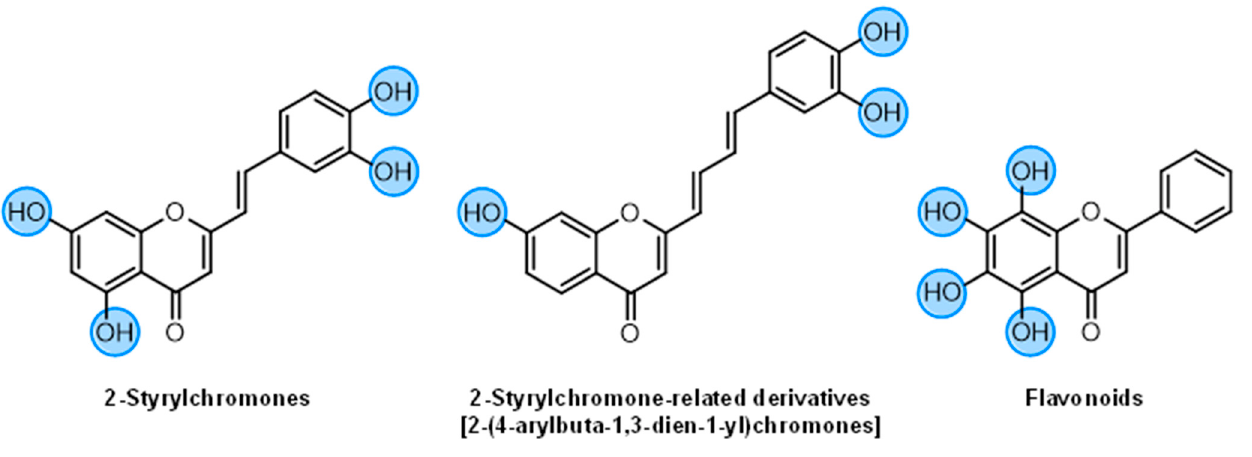
Figure 7. Structure–activity relationship of chromone derivatives: 2-styrylchromones, 2- styrylchromone-related derivatives [2-(4-arylbuta-1,3-dien-1-yl)chromones], and flavonoids, which contributed to increased GP inhibitory activity.